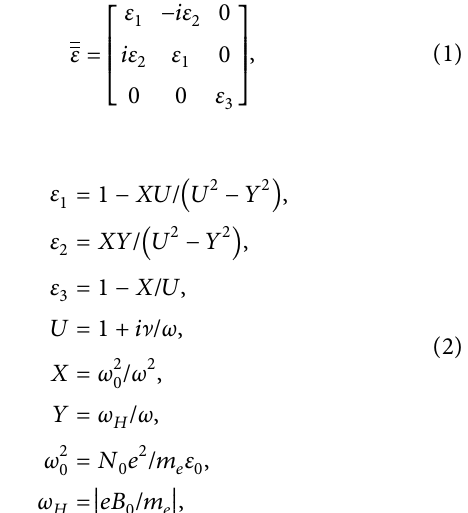
I and an insulation layer in region II. a and b are outer radii of the conductor and insulation layer, respectively. The permeability of each region μ equals to that of free space μ ≈ ( iωμε σ ) 1/2 and for the insulation layer are ε 0 I � ω [ με k ( ε + i σ / ω )] 1/2 , respectively. The medium in the II 0 II II IIIrd region is the anisotropic ionosphere. The length of the antenna is 2 l . The antenna is parallel to the geomagnetic field with the amplitude B . The antenna is driven by applying 0 feeding voltage V , which denotes the Dirac function δ ( z ) at 0 its center across a thin gap to generate electromagnetic